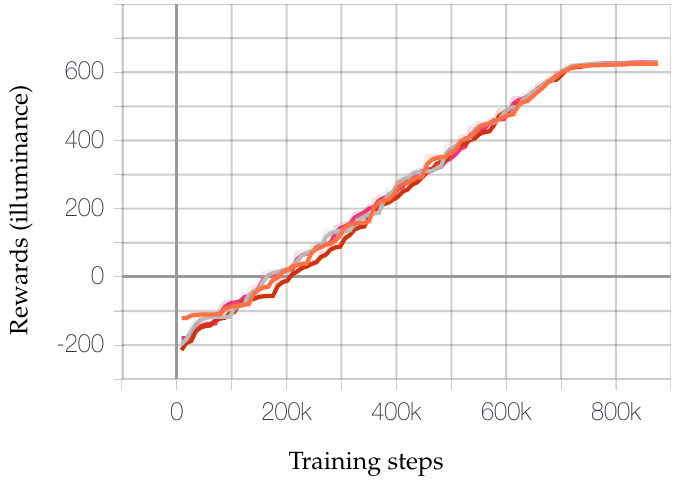
Figure 8. Top jobs achieving rewards (illuminance) over the training